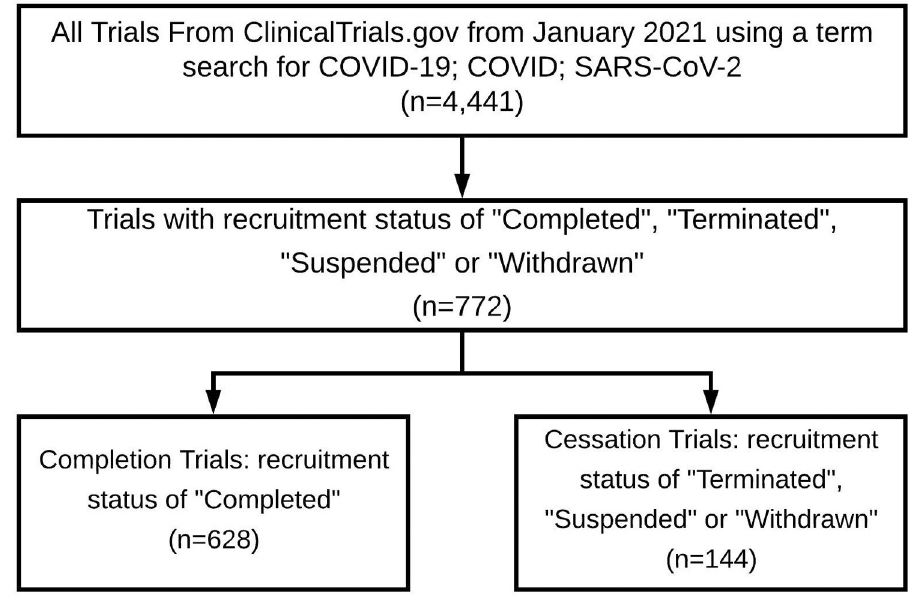
Fig 2. Data inclusion criteria for COVID-19 clinical